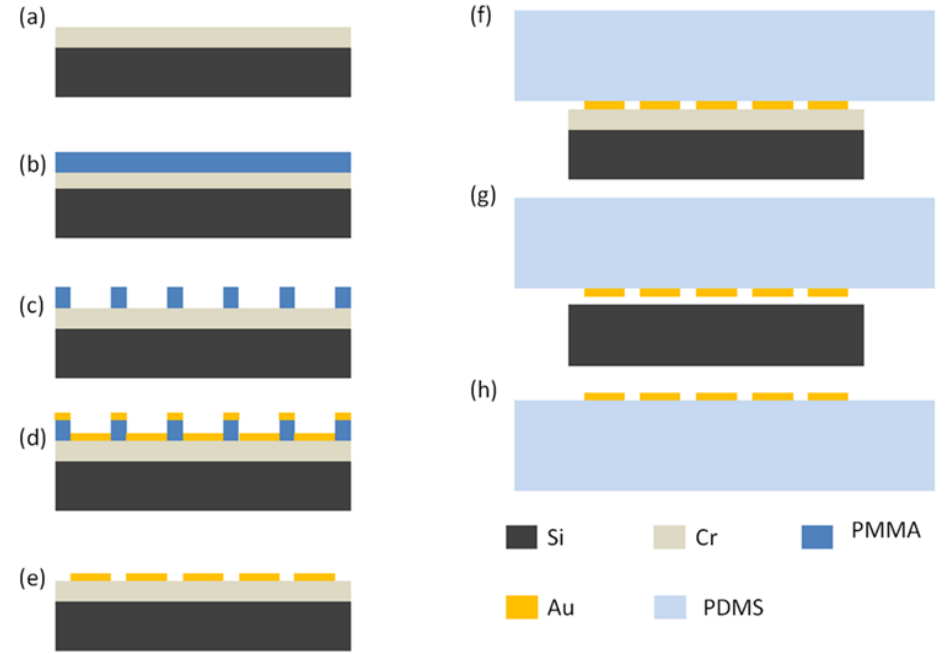
Figure 1. Flexible optical device fabrication flow chart: ( a ) chromium evaporated on substrate; ( b ) resist is spin coated on the chromium surface; ( c ) The designed structure is exposed on the substrate through lithography and development; ( d ) gold evaporation ( e ) lift off; ( f ) flexible substrate is pressed onto the structures; ( g ) Cr sacrificial layer etched off; ( h ) successful transfer of gold structures.